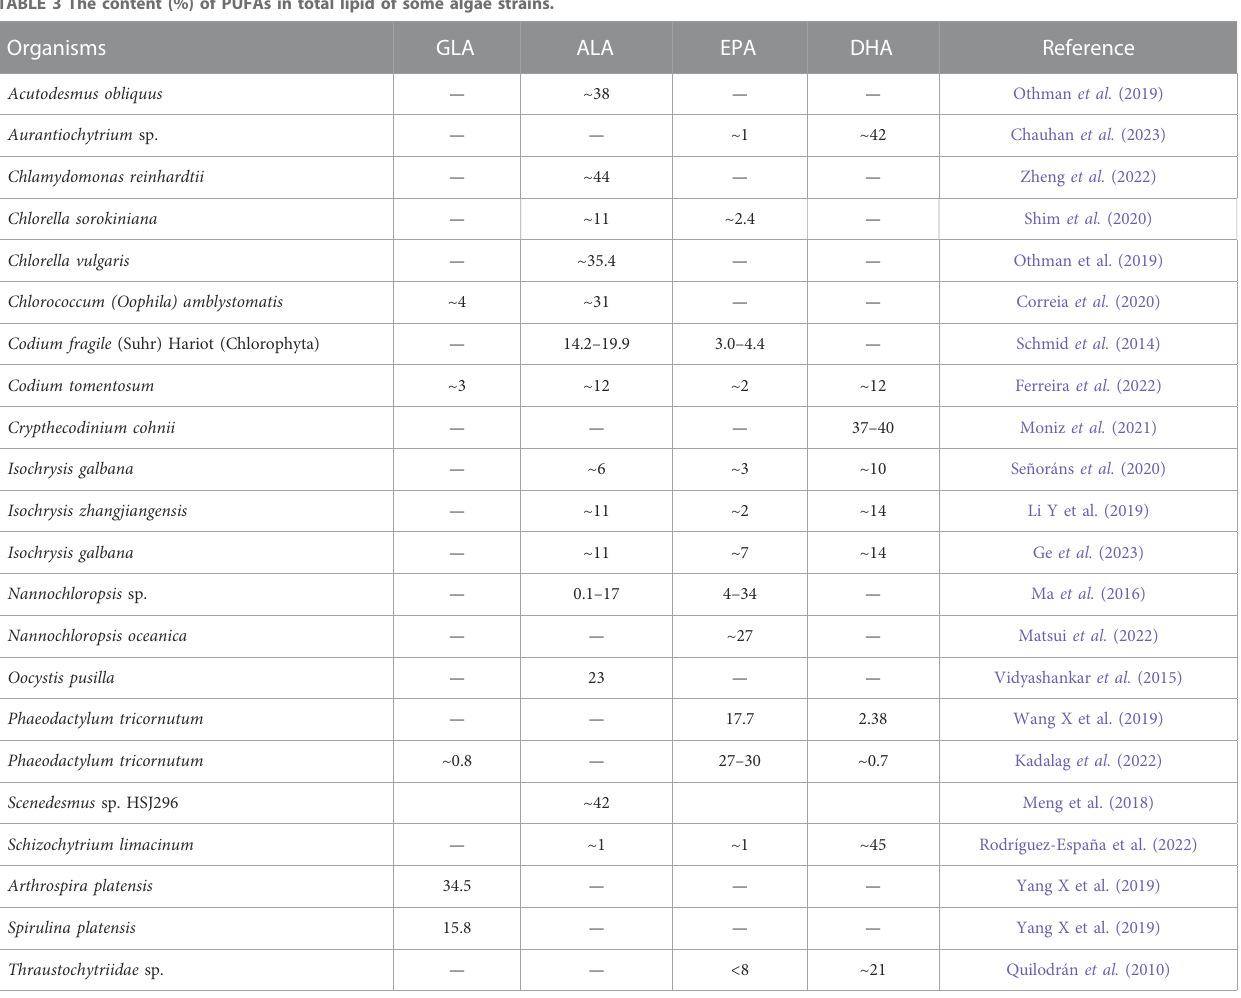
TABLE 3 The content (%) of PUFAs in total lipid of some algae strains. Organisms